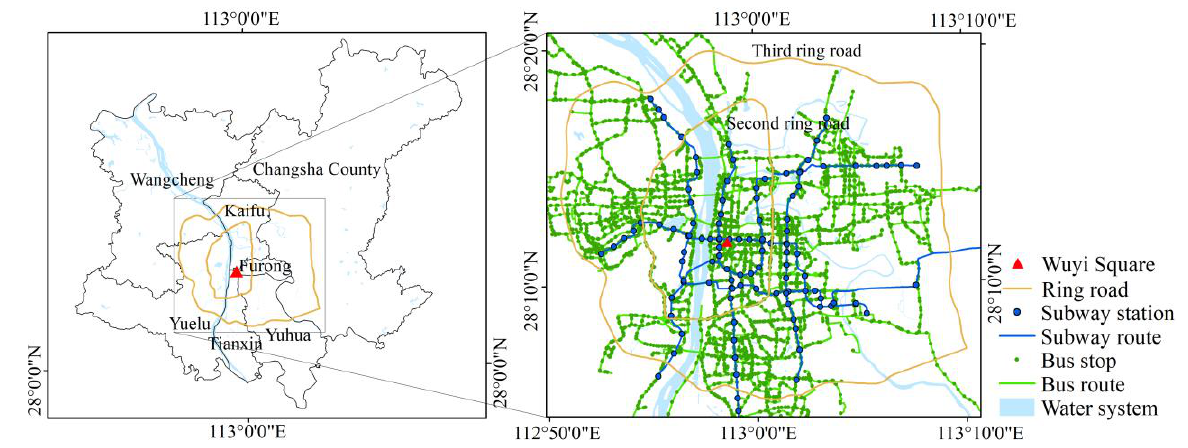
Figure 1. Study area.